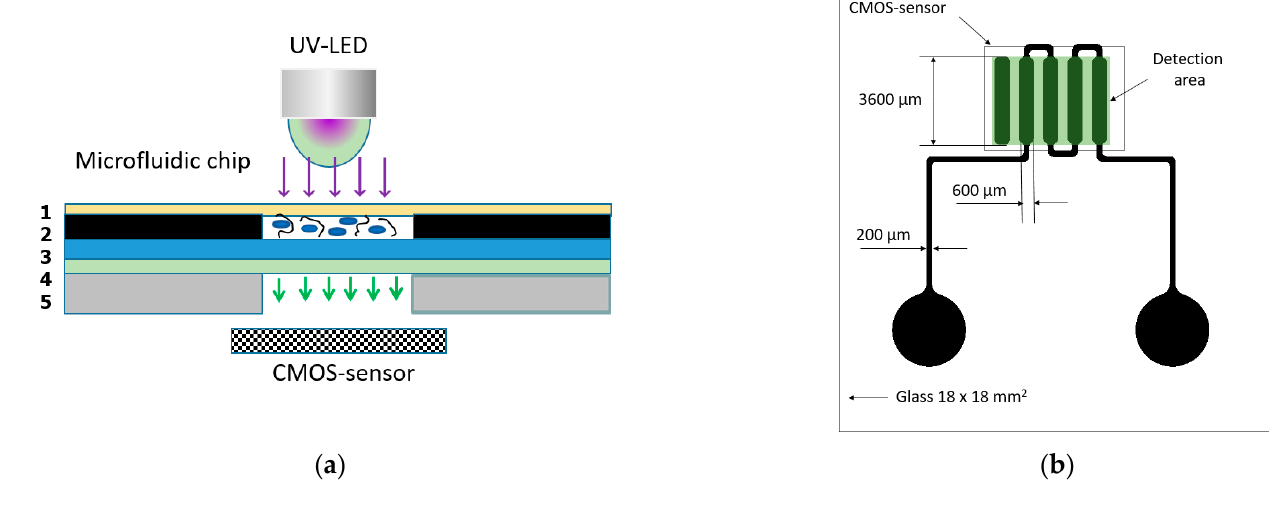
Figure 1. The schematic of biosensor system design and microfluidic system topology. Cross-section view of a sandwich structure of a microfluidic system of biochip with integrated biorecognition elements ( a ): 1—a sealing layer and optical window for inlet UV radiation (polypropylene); 2—a microfluidic system with microchannels and platforms for integrating biorecognition elements (photoresist); 3—a cover glass substrate; 4—a luminophore layer (ZnS: Cu); 5—PETF casing. Topology of a microfluidic system ( b ).